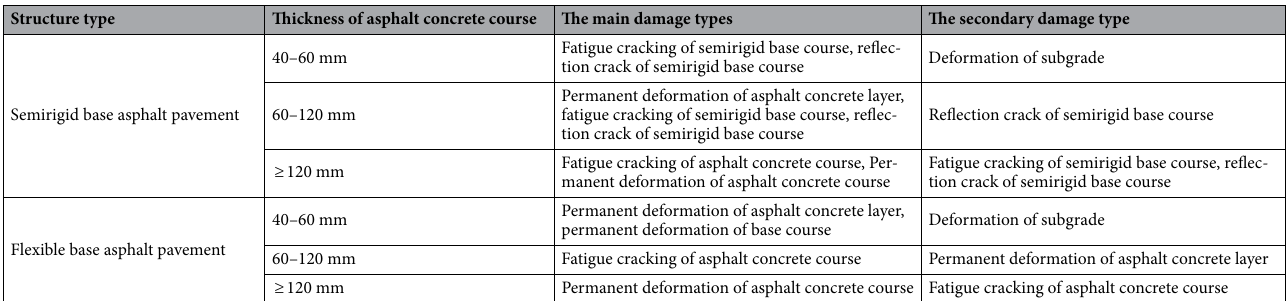
Table 4. The relationship between the asphalt pavement structure and the main damage